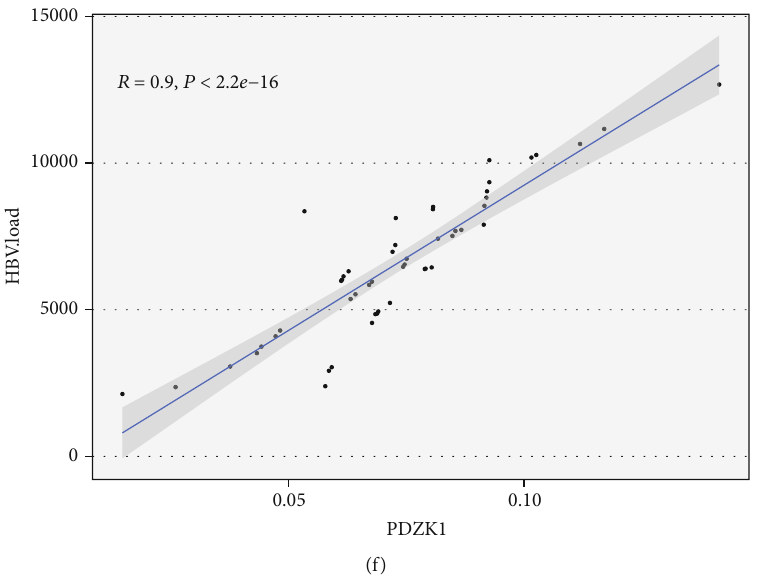
Figure 2: PDZK1 is one of the HBV-infection-related oncogenes in human HCC. (a) Venny map indicating the common up- or downregulated genes both in cancer and normal samples from TCGA-LIHC. (b) Heat map re fl ating either R or P value obtained from multiple correlation study between HBV reads and gene expression level of common genes. (c) Scatter plot re fl ecting the correlation between HBV reads and PDZK1 expression in the TCGA samples. (d) The comparison of PDZK1 expression between normal and tumor samples from TCGA-LIHC or TCGA-LIHC and GTEx database. (e) Real-time PCR detection PDZK1 transcription in the sample sets indicated in the fi gure. (f) Scatter plot re fl ecting the correlation between HBV reads and PDZK1 expression from clinical